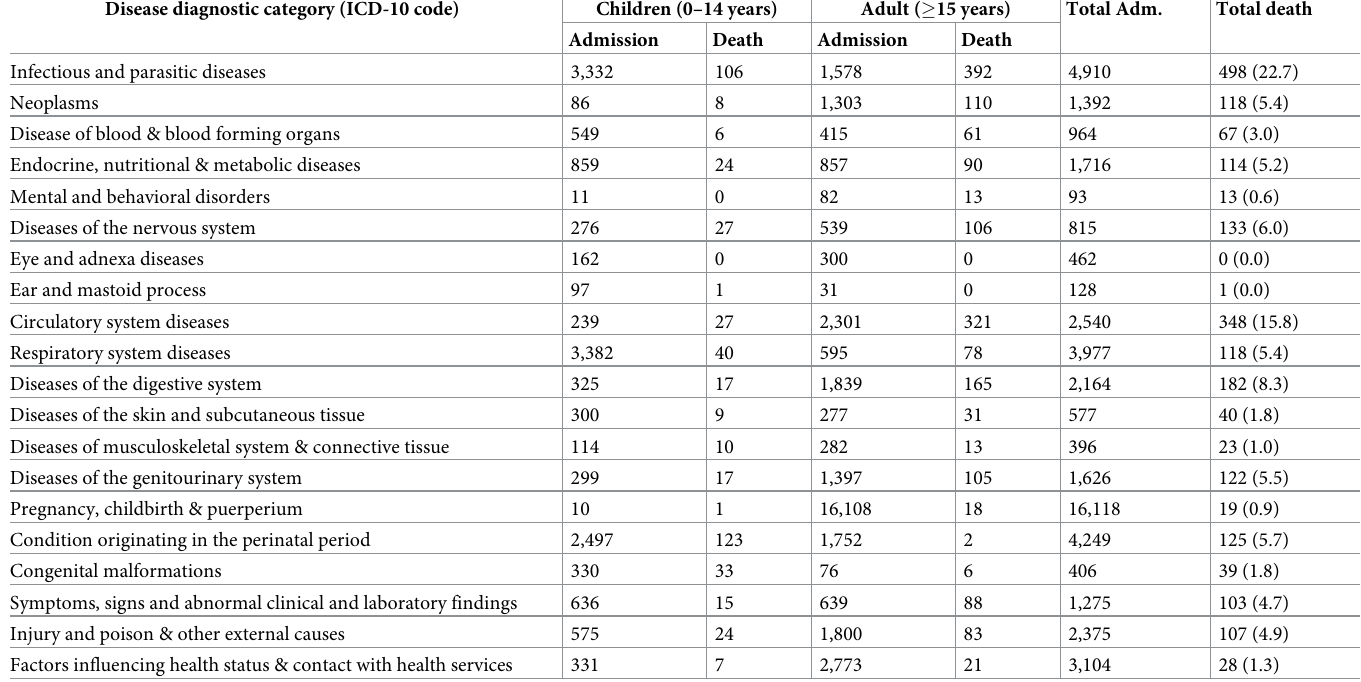
Table 3. Distribution of causes of morbidity and mortality by broad ICD-10 classification. Disease diagnostic category (ICD-10